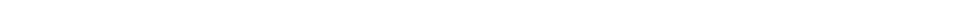
(see fi gure on previous page) Fig. 1 Neuroticism with overall or cognitive decline speci fi c cortical co-expression gene modules. A The impact of neuroticism on the overall cortical co-expression gene modules. Each dot represents one module and its expected and observed associations with neuroticism ( − log10 P values) are shown on X and Y axis, respectively. The expected P values assume a null distribution with no linear associations between neuroticism score and expression level of co-expressed gene module after adjusting age at death, sex, education, race, postmortem interval, study (ROS or MAP), RNA-seq batch and RIN score. The gray and dark areas indicate the extreme ranges of the QQ plot as generated by chance at a threshold of P = 0.05 and P = 0.10, respectively. The 95 and 90% con fi dence intervals were empirically derived by randomly assigning participants with the neuroticism score and repeating the analysis 1000 times. Based on the distribution of the observed P values for all the 47 co-expressed gene modules, the overall association between neuroticism and module expression was unlikely to have occurred by chance (omnibus P = 0.005). B The impact of neuroticism on the cognitive decline related co-expression gene modules. Each dot represents one module (the module number is listed next to each dot) and their previously reported P values for the cognitive decline 6 are shown on the Y axis and the P values ( − log10 transformed) of the effect of neuroticism are shown on the X axis with the red dashed line for the threshold of P = 0.05. The red dots are those that were previously reported to be associated with cognitive decline 6 . C , D Distribution of cortical module m7 and m127 expression in individuals with different levels of neuroticism. Each dot represents one subject, and the subjects are distributed into three groups based on their neuroticism score: Group 1 with score from 0 to 12; Group 2 with score from 13 to 24; Group 3 with score from 25 to 36. On this scale, scores go from 0 (no neuroticism) to 36 (extensive neuroticism). E Volcano plot of the associations between neuroticism score and mRNA expression level of each of the 499 genes included in the top 4 modules associated with both neuroticism and cognitive decline with color codings of m7 in purple, m6 in blue, m127 in green, and m131 in red. F Volcano plot of the associations between neuroticism score and the 11 previously reported cognitive decline associated co-expressed gene modules with color codings of different cell type: astrocyte in red, cholinergic neuron in green, GABAergic neuron in blue, and other excitatory neuron in purple. For both volcano plots, X axis shows the BETA and Y axis shows the − log10 transformed P values with the red dashed line represents the threshold of P =